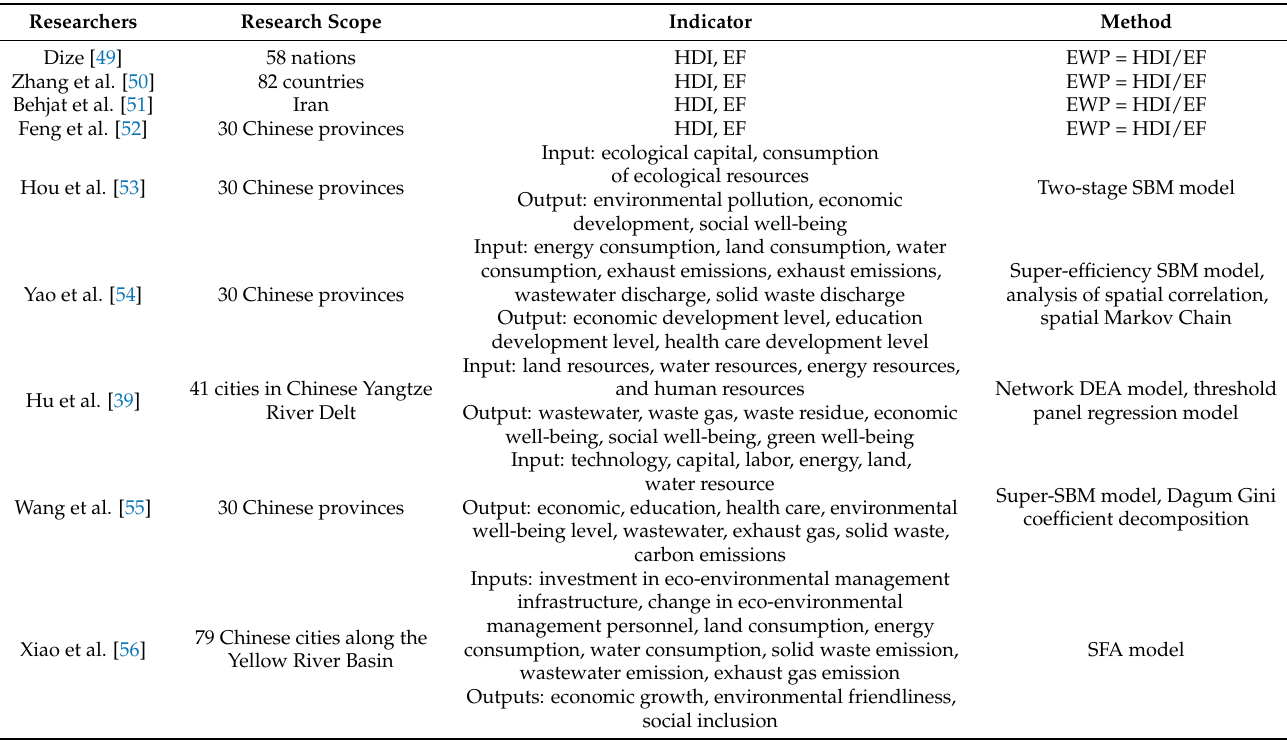
Table A1. Review of the EWP evaluation methods.